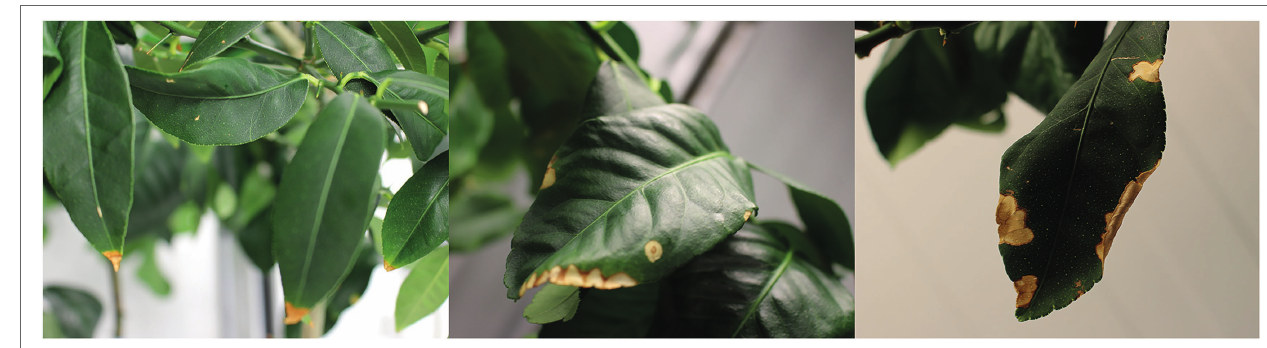
FIGURE 4 | Visual damage to the leaves after 7 months of irrigation with nutrient solutions of different characteristics—Control, DSW, and DLB—for ‘Verna’ lemon plants grown on two rootstocks, Citrus macrophylla (CM) and sour orange